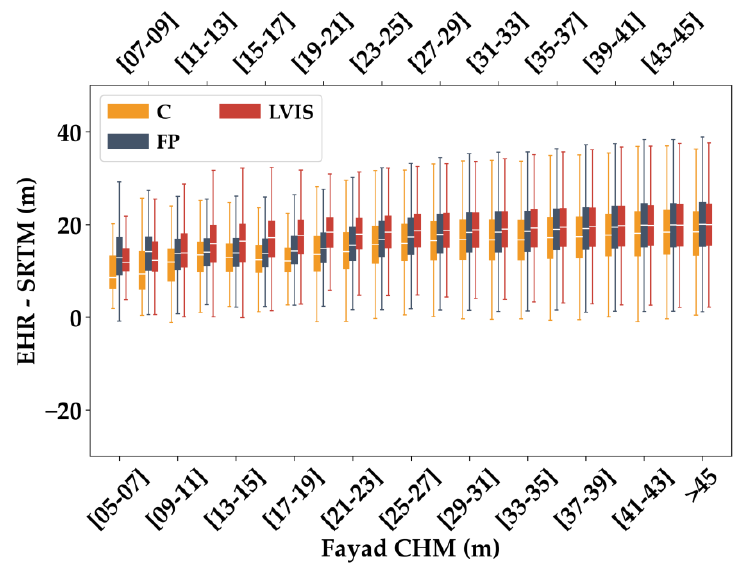
Figure 8. Boxplots of the difference between the elevation of each waveform’s highest return (EHR) and SRTM from GEDI’s coverage (C) and full-power (FP) lasers, as well as those from LVIS. Only waveforms with sensitivity ≥ 98% were selected.